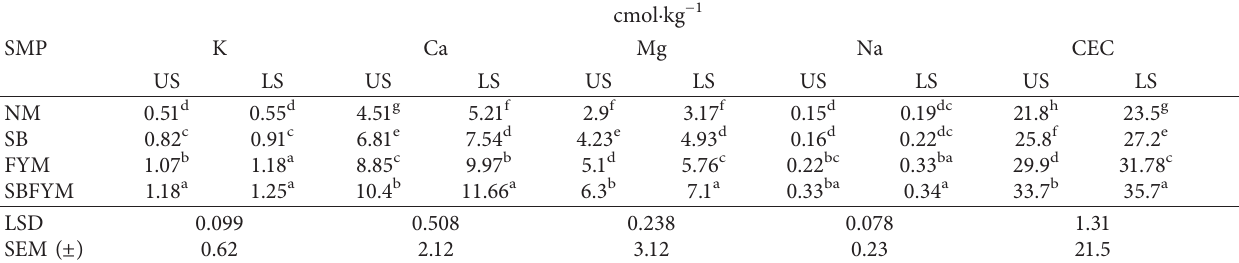
Table 7: Interaction effect of soil management practices and slope ranges on exchangeable cations in soils of Mawula watershed. SMP SBFYM